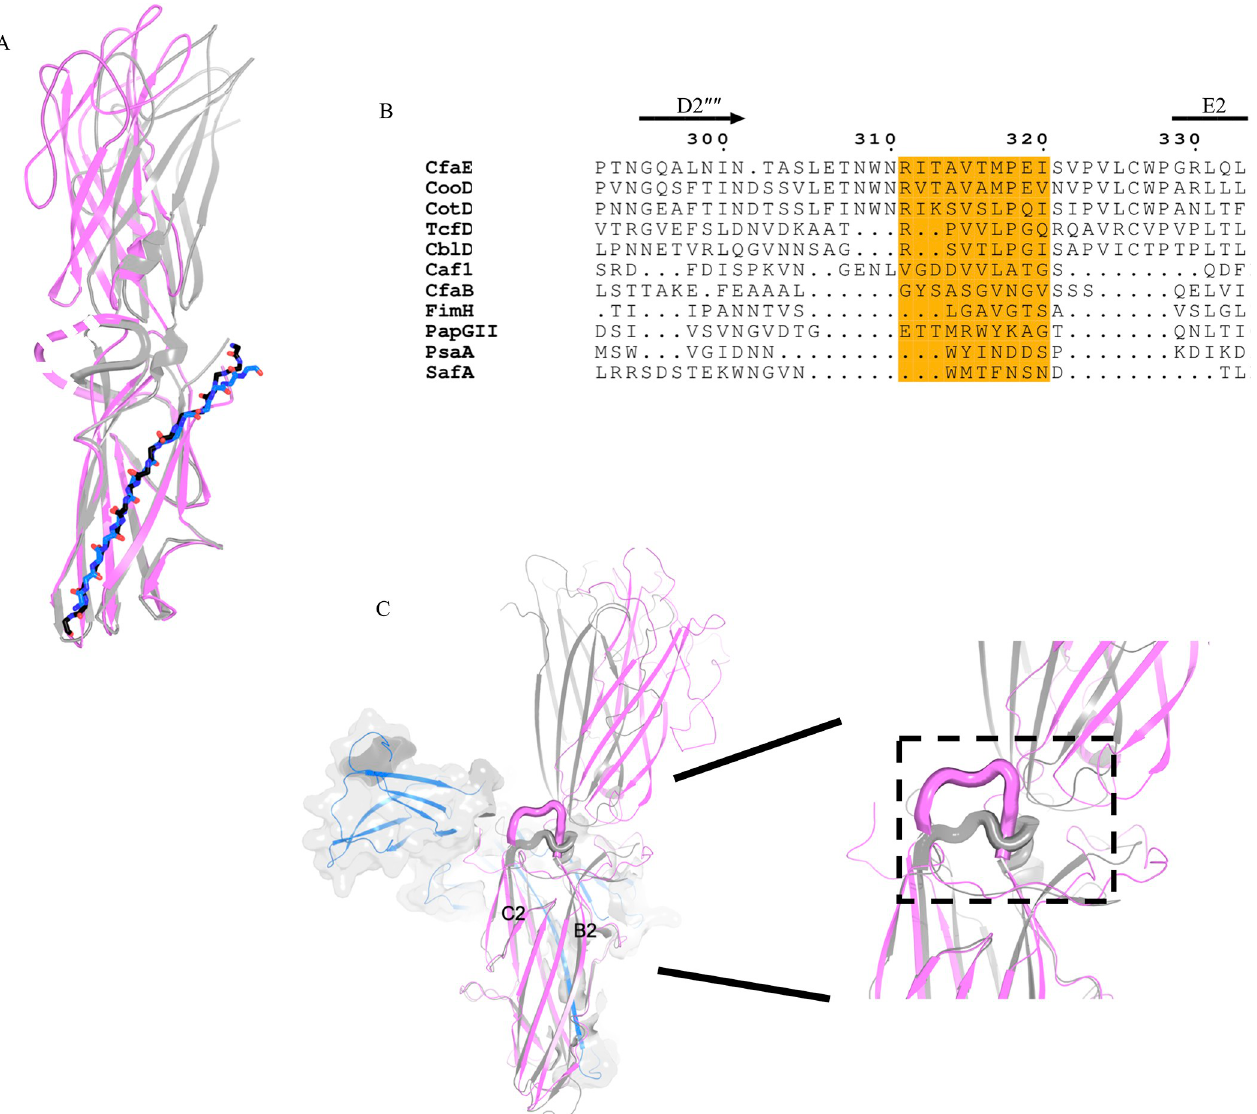
Fig 5. Inter-domain motions of CfaE. (A) Superimposed cartoon models of the pilin domain of CfaE from mtCfaA-CfaE (magenta) and CfaB-CfaE (gray) (PDB:3F83). The Gd strand of CfaB is in black sticks and the G1 stand of CfaA is in blue. The disordered loop 301–321 in mtCfaA-CfaE is shown as dashed line. (B) Sequence alignment of the flexible loop region, shaded in orange, from different adhesin subunits. Besides FGA fimbrial adhesins, FimH from Type I pili, PapG from P-pili, SafA from Salmonella atypical fimbriae and PsaA from the pH 6 antigen on the surface of Yersinia pestis are also included in the alignment. (C) Superposing the pilin domain of CfaE of the mtCfaA-CfaE complex (magenta) with that of CfaB-CfaE complex (gray), the CfaE loop (residues 241–248) connecting β -strands B2 and C2 and shown in thicker lines involved in domain interactions.